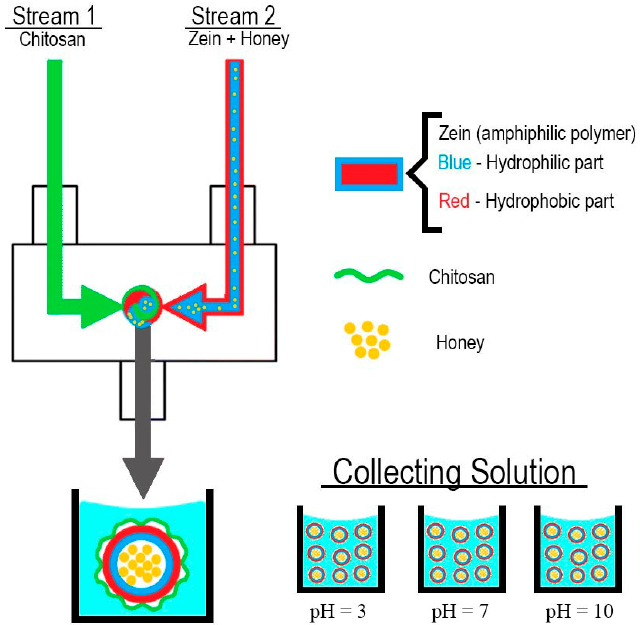
Figure 1. The proposed approach for zein–honey–chitosan NPs synthesis by